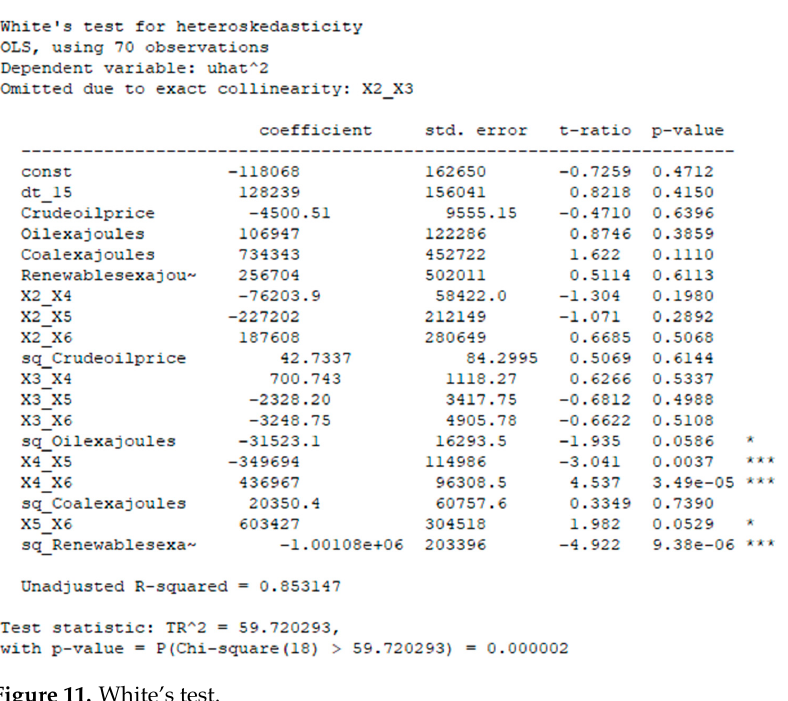
Energies 2023 , 16 , x FOR PEER REVIEW Figure 11. White’s test. Figure 11. White’s test.